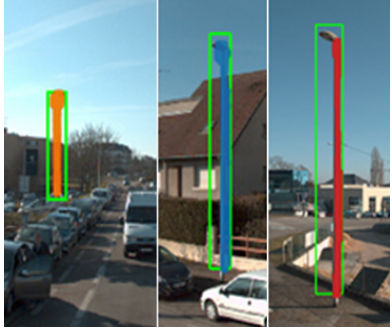
Figure 2. Examples of the instance segmentation results.